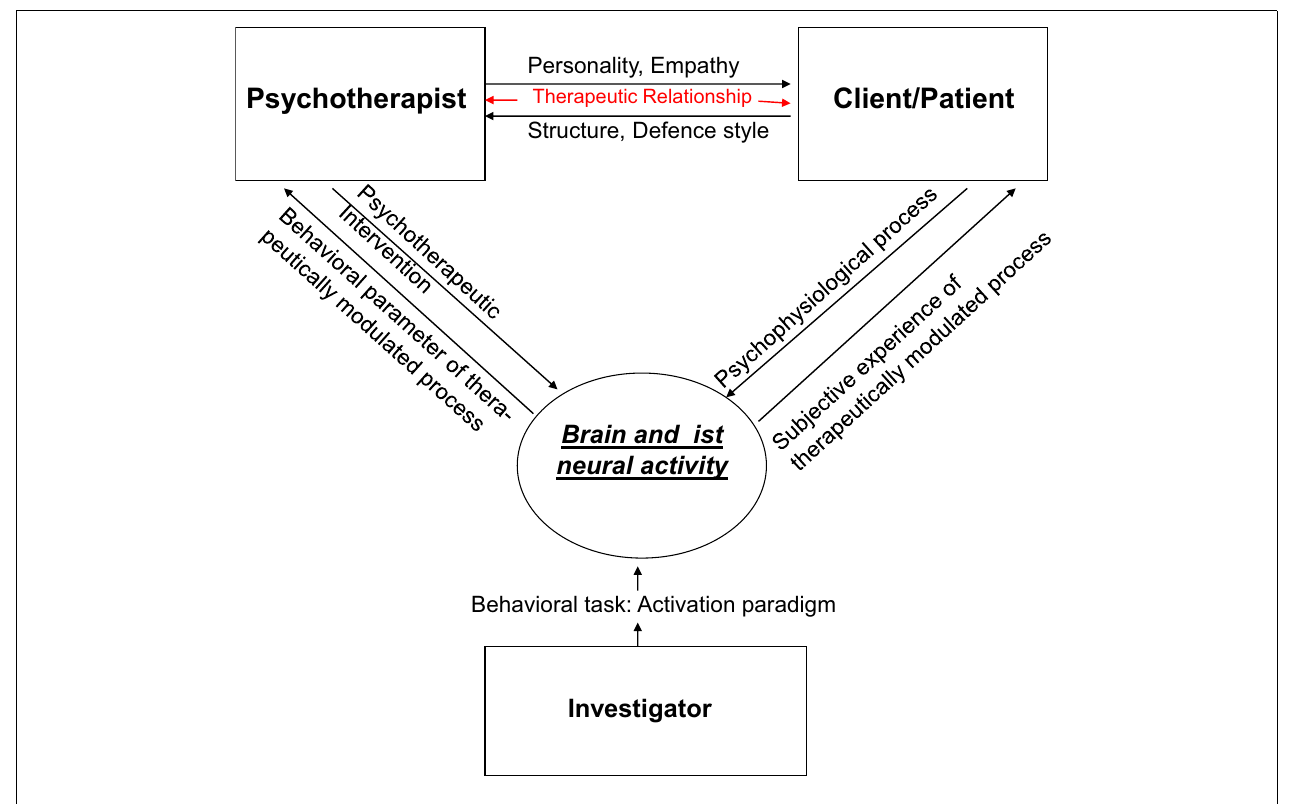
FIGURE 1 | The design